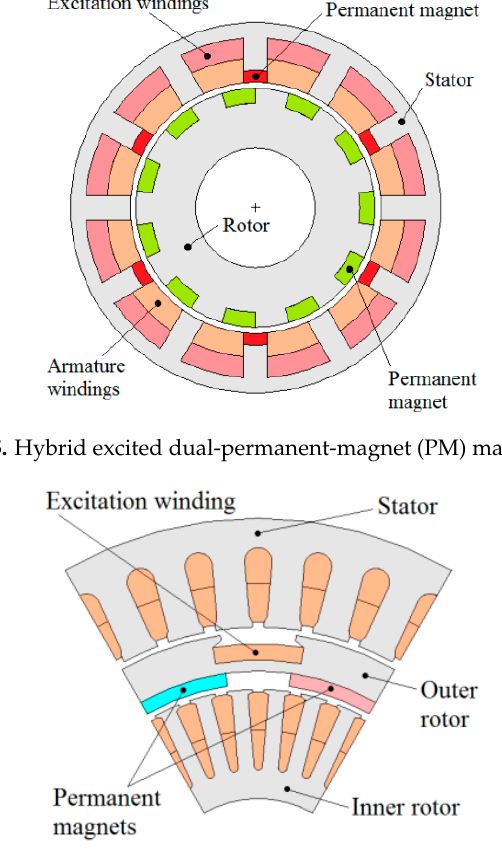
Figure 6. Electrical variable transmission with hybrid excitation [32,33].